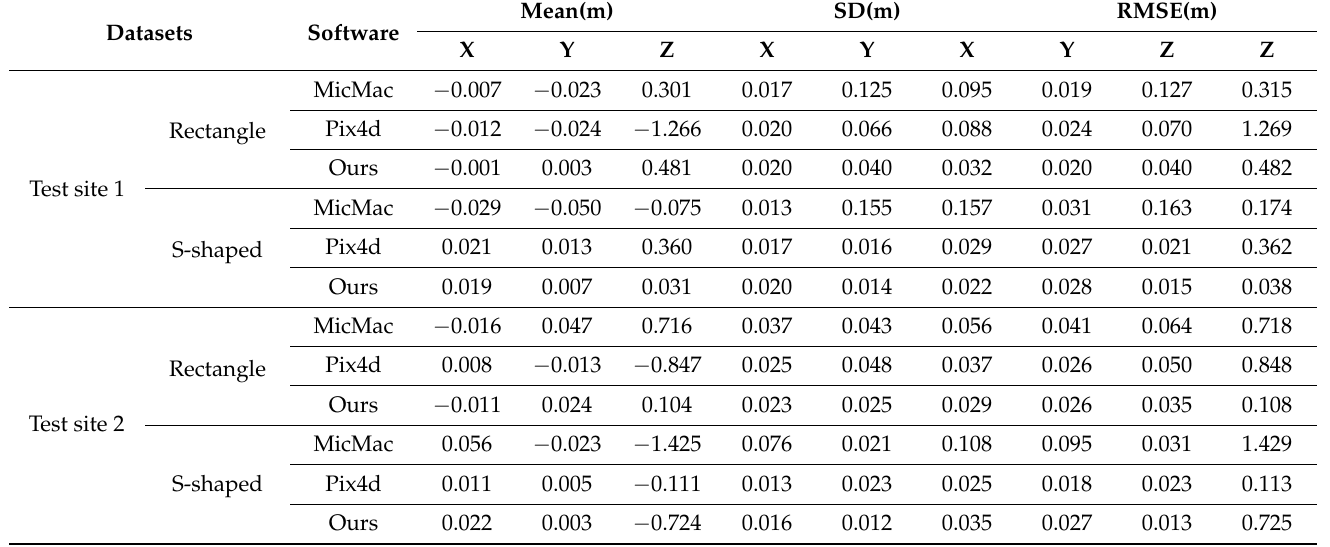
Table 5. Statistical results of self-calibration for different